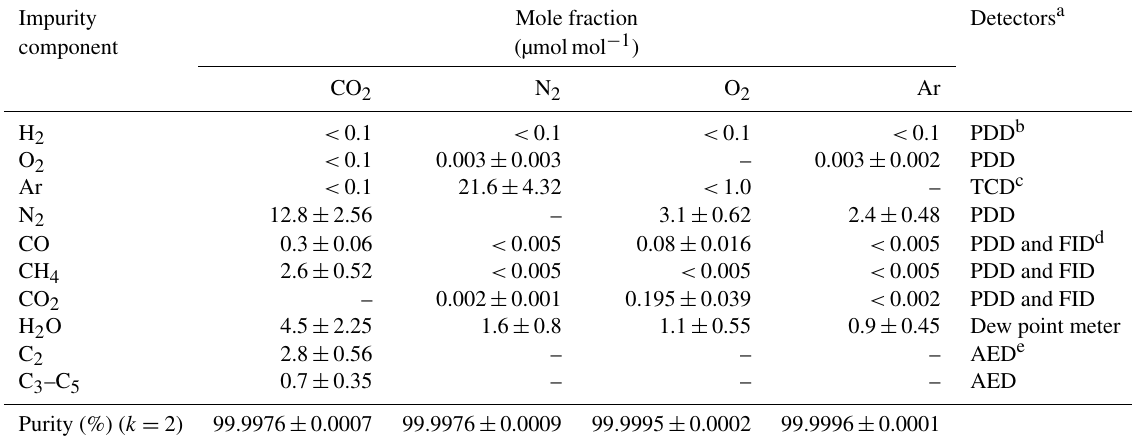
Table 1. Purities of raw carbon dioxide and background gases (N 2 , O 2 , and Ar). Impurity Mole fraction Detectors a component (µmolmol − 1 )